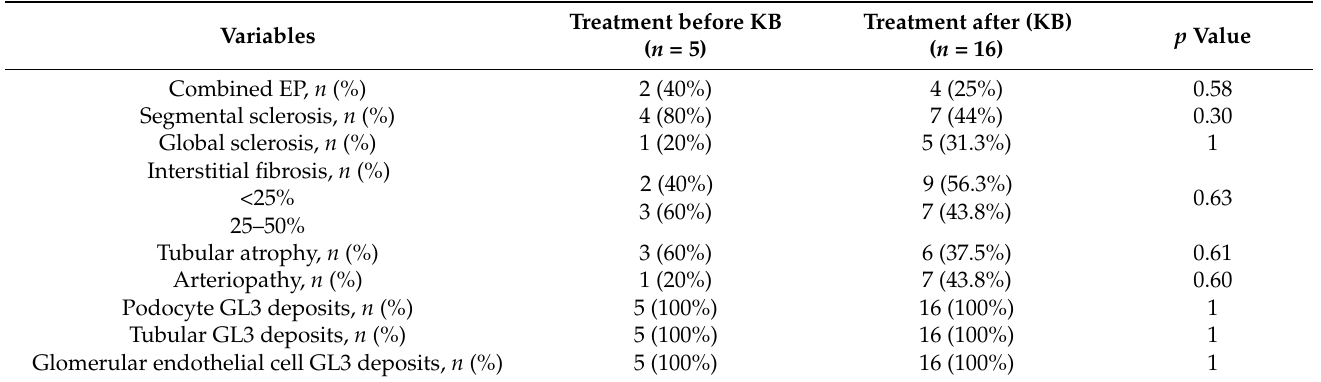
Table 5. Subgroup comparison analysis between patients who started the Fabry specific therapy before and after the kidney